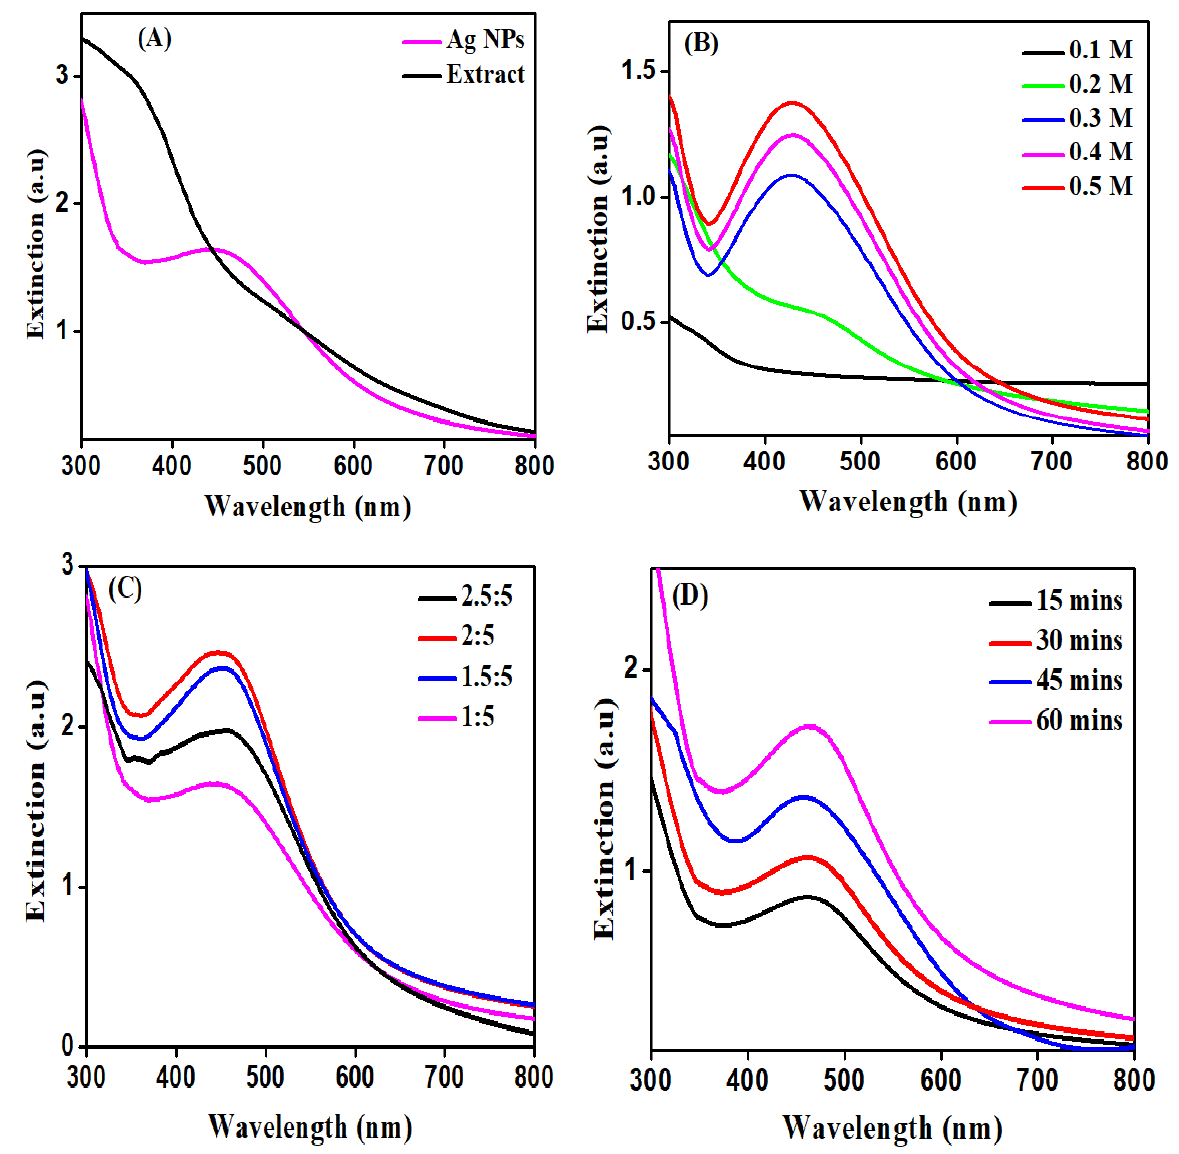
Figure 1. UV–visible analysis of Ag NPs and plant extract ( A ) UV–visible analysis of Ag NPs at Figure 1. UV – visible analysis of Ag NPs and plant extract ( A ) UV – visible analysis of Ag NPs at different AgNO 3 concentrations ( B ) UV – visible analysis of Ag NPs at different volume ratio of aque- different AgNO 3 concentrations ( B ) UV–visible analysis of Ag NPs at different volume ratio of ous silver salt and plant extract ( C ) UV – visible analysis of Ag NPs observed at different time inter- aqueous silver salt and plant extract ( C ) UV–visible analysis of Ag NPs observed at different time vals ( D ). intervals ( D